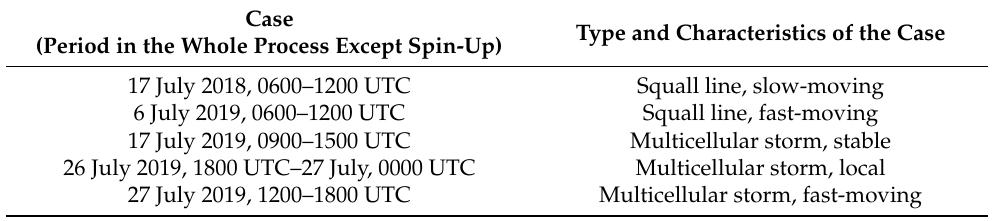
Table 2. Multi-type cases for cycling data assimilation and forecasting.